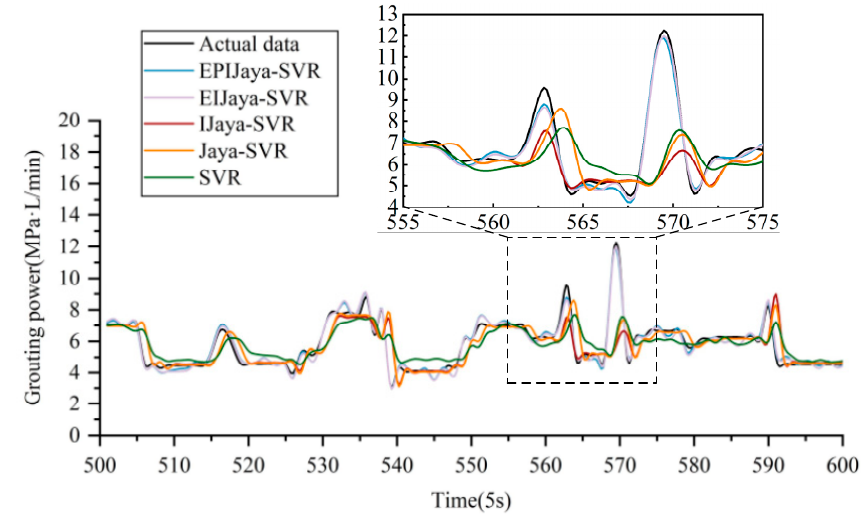
Figure 9. Actual grouting power and the prediction results of different models.